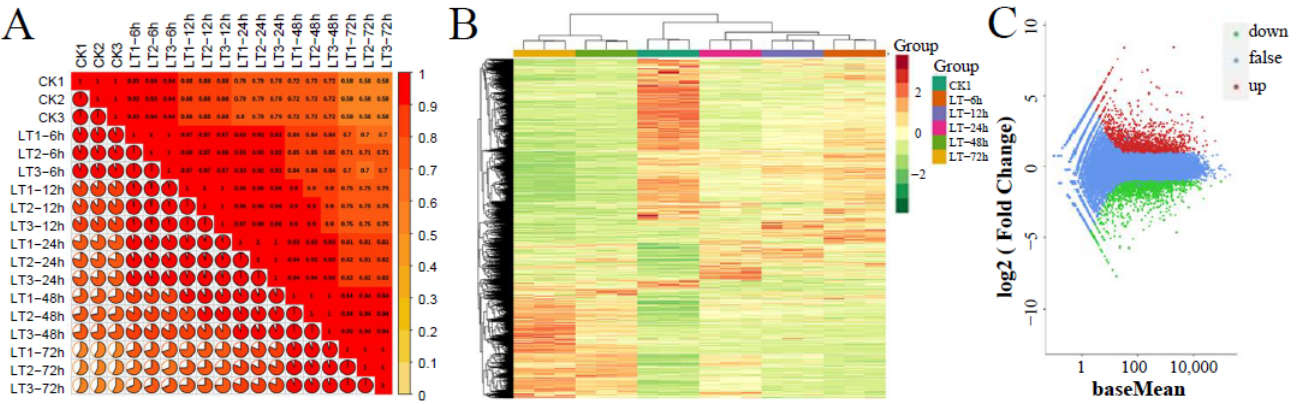
Figure 3. Differential expression analysis and clustering of DEGs. ( A ) Heat map of correlation coefficient values across samples based on RNAseq FPKM. ( B ) Cluster analysis of DEGs. ( C ) Volcano plot of DEGs of cold treatment at 6 h.